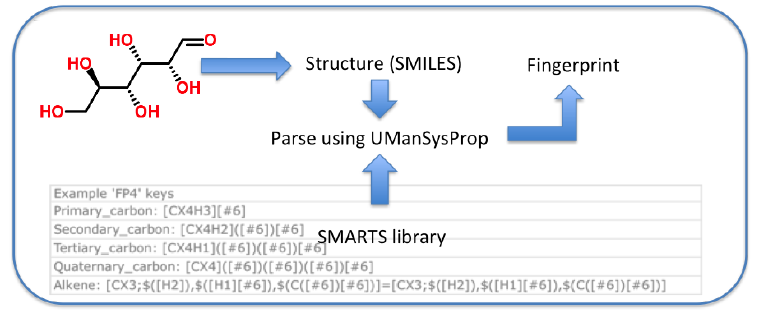
Figure 2. Basic schematic of interrogating a SMILES string with a SMARTS library to construct a molecular